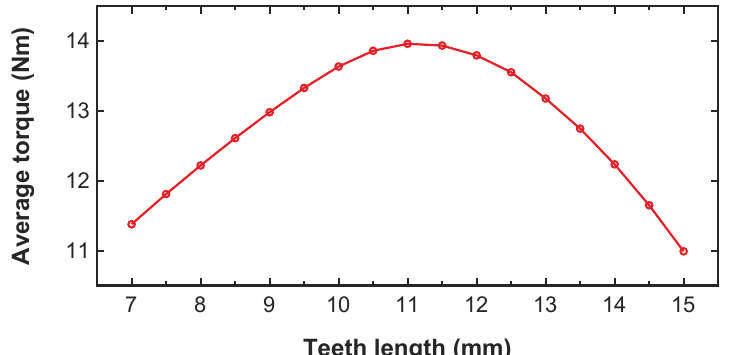
Figure 14. Relationship between tooth length and average torque.